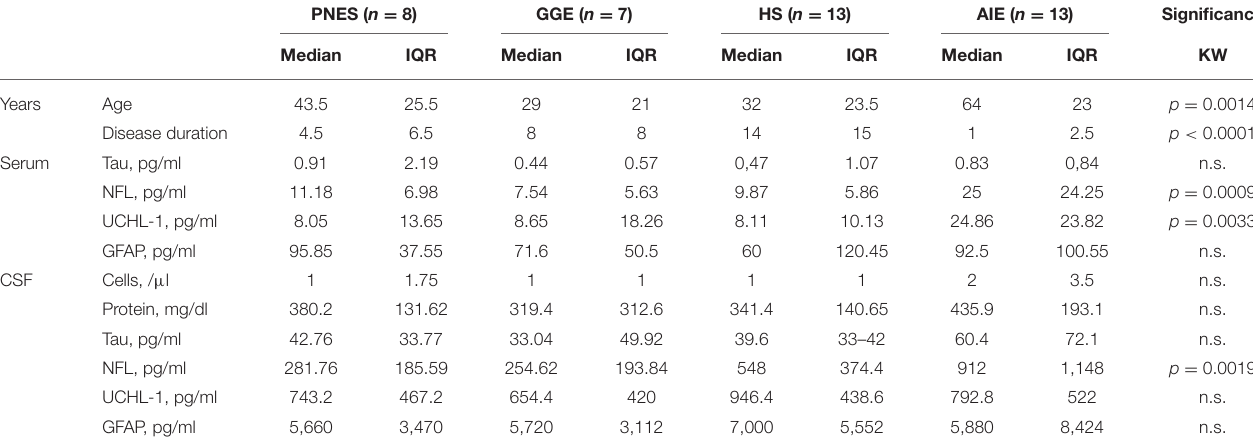
TABLE 2 | Clinical characteristics